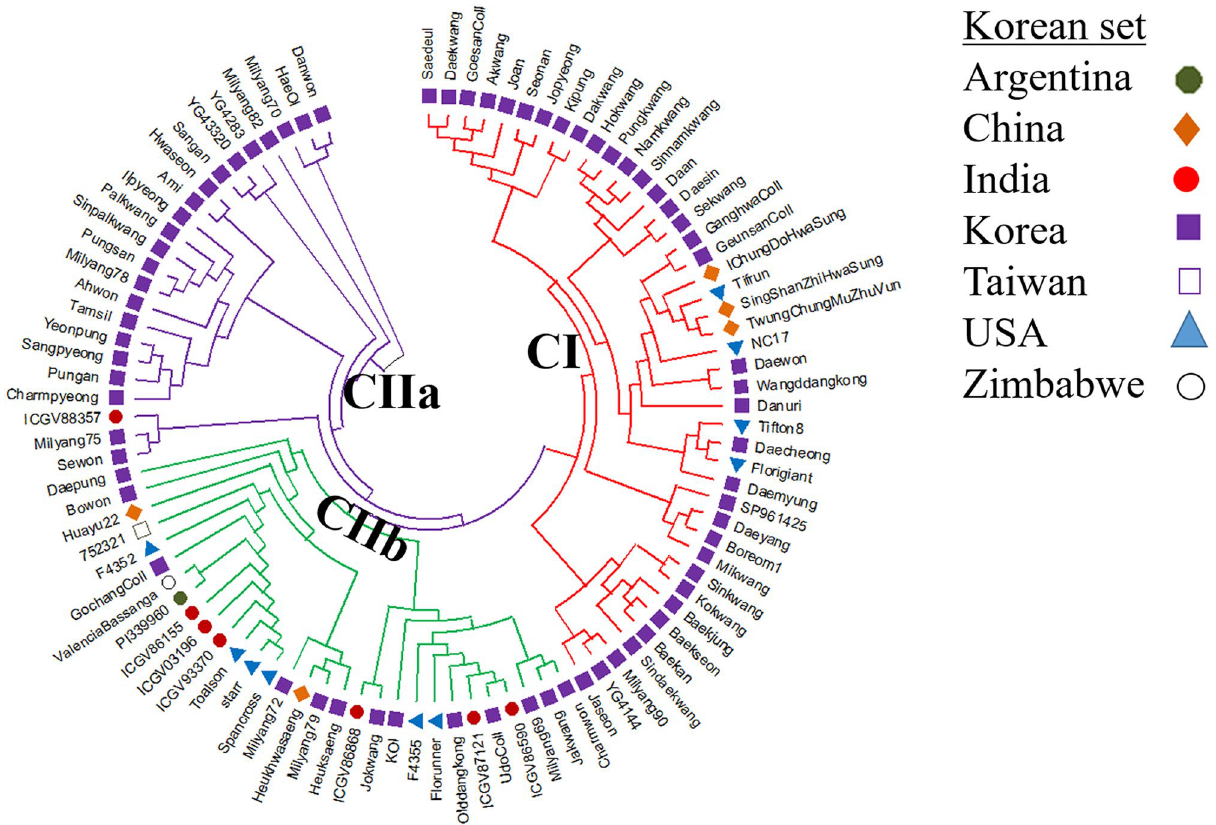
Figure 4. Phylogenetic tree of the Korean set of peanut genotypes (n = 96) constructed using MEGA X software (http:// www. megas oftwa re. net/.) with a neighbor-joining method 44 . These genotypes were clustered into two major clusters. The second cluster was subdivided into CIIa and CIIb, with each colored branch representing respective clusters (CI, red; CIIa, purple; CIIb, green). The leaf node symbol represents the respective country mentioned in the